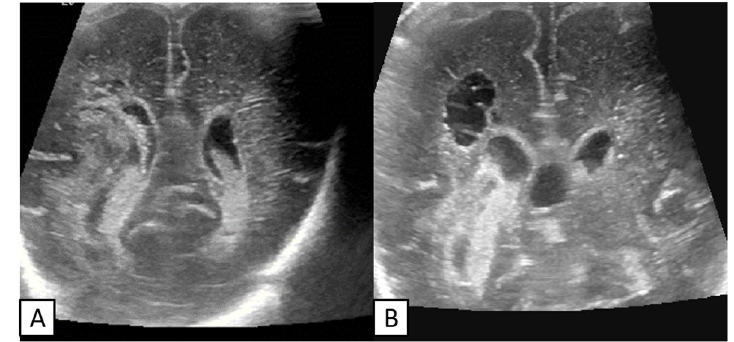
Fig. 2 CUS images in a pre-term neonate showing PVL (grade 2) ( A ) with progression into cystic PVL in a follow-up scan ( B